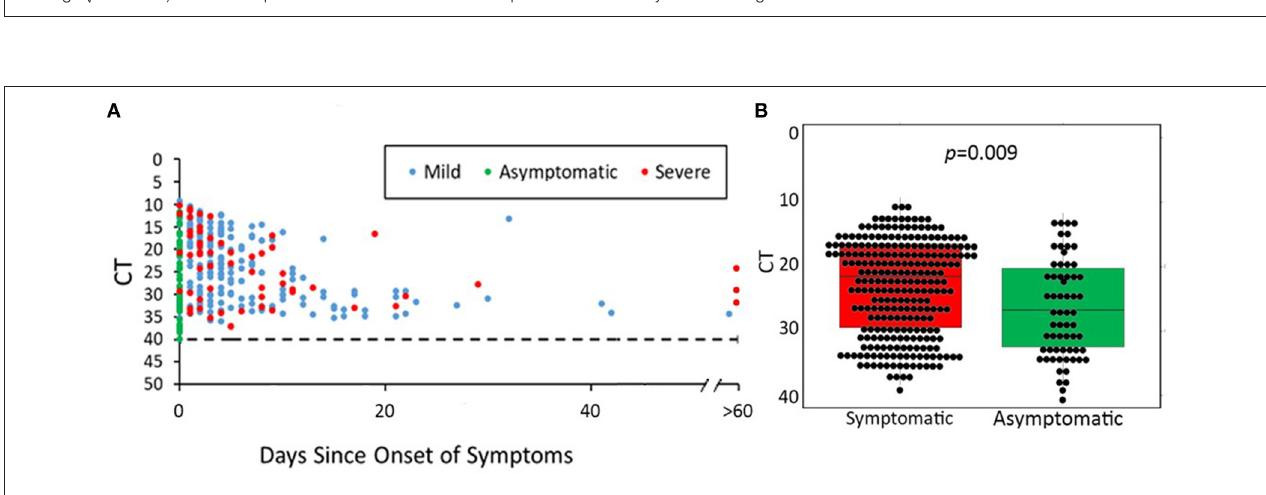
FIGURE 4 | SARS-CoV-2 PCR cycle threshold (Ct) for available nasopharyngeal specimens (NP) from 475 youth with COVID-19. (A) Days of symptoms vs. cycle threshold (Ct) according to COVID-19 severity. (B) Median Ct values of positive PCR results in symptomatic vs. asymptomatic youth. (A) shows SARS-CoV-2 Ct values according to days since symptom onset for each positive SARS-CoV-2 PCR test. A symptomatic/pre-symptomatic cases were distributed along the entire height of the y -axis from Ct values of 10 (representing the highest viral load) to Ct values of 40 (negative cutoff for a positive RT-PCR result). Mild/moderate cases represented the majority of data points ( n = 213) and demonstrated a wide range of Ct values (10–40). Severe cases were fewer in number ( n = 59) and generally had lower Ct values. (B) Median PCR Ct values of asymptomatic youth were significantly lower than that of symptomatic youth (21.5 vs. 26.7, p =